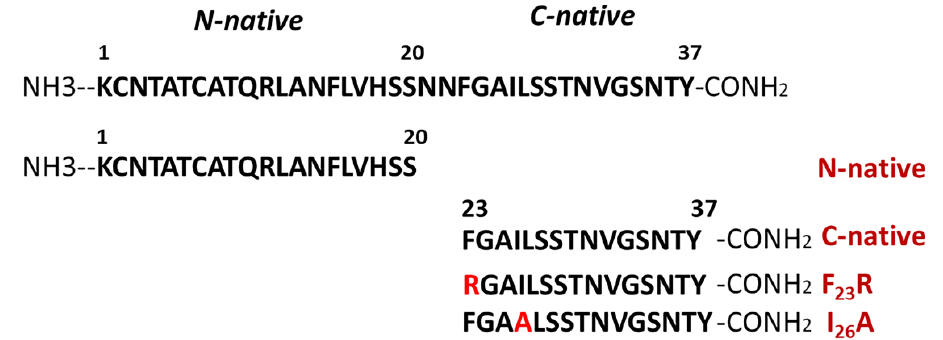
Figure 1. Representation of the primary structure of human islet amyloid polypeptide (hIAPP) and peptides corresponding to N-native and C-native domains, as well as new variants of hIAPP.